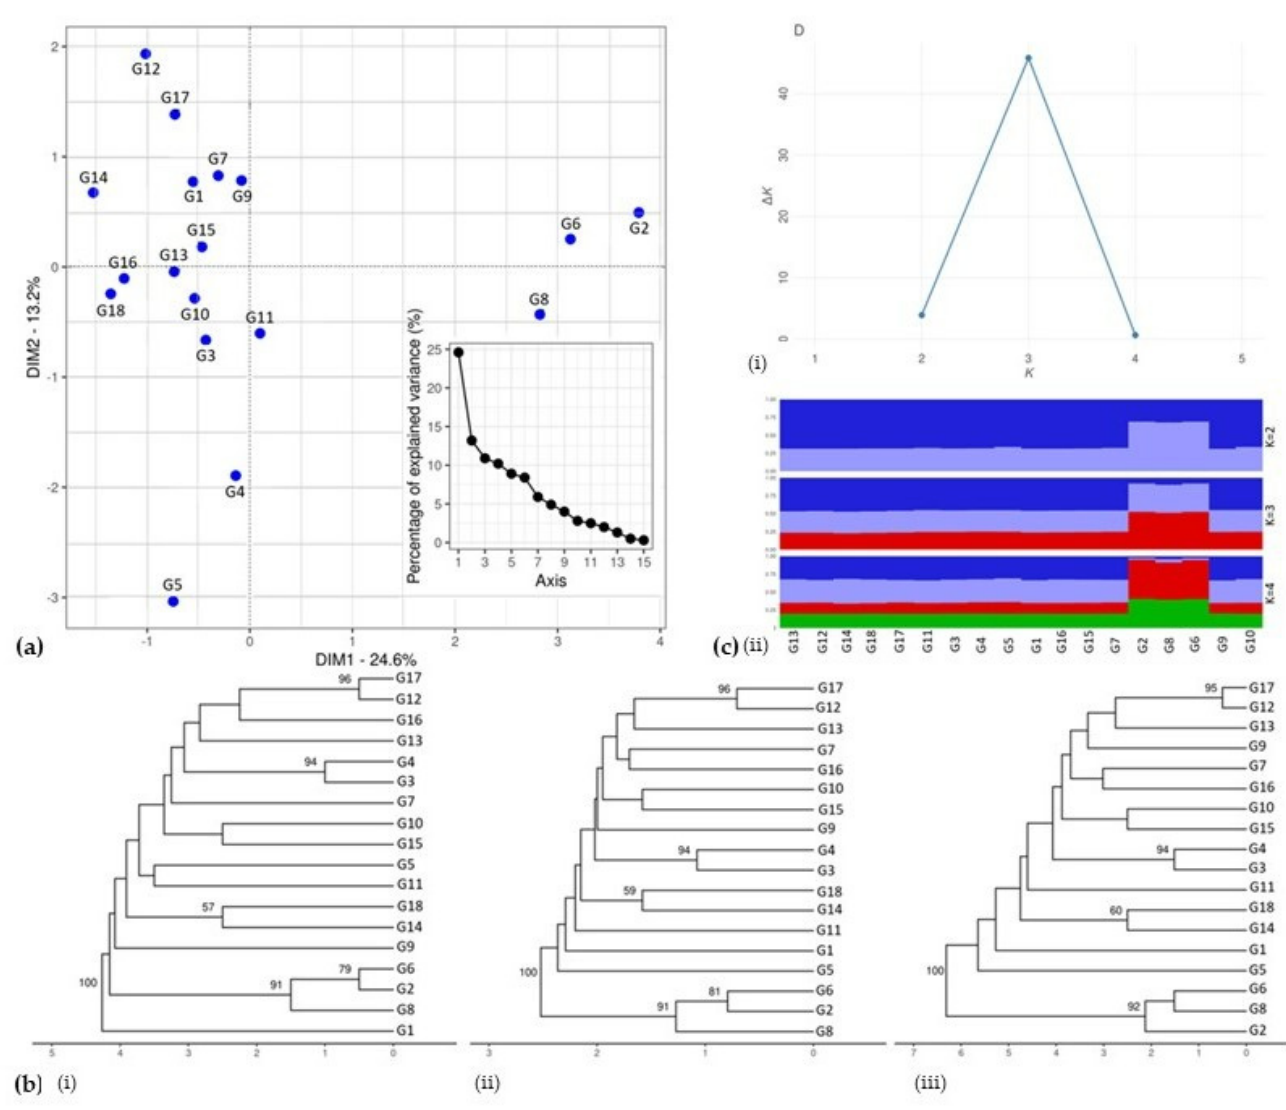
Figure 5. ( a ) Principal Coordinate Analysis (PCoA) plot of 18 native Greek rock samphire genotypes (Table 1) with the percentage of the explained variance (%) demonstrated on the right side of the figure. ( b ) UPGMA dendrogram computed by using three distance measures, i.e., (i) Relative dissimilarity matrix, (ii) Euclidean Distance, and (iii) Smouse and Peakall distance. ( c ) Distribution of 18 rock samphire genotypes according to molecular data of 8 SSR loci in the Structure software with (i) values of Evanno’s Δ K statistic indicating the most probable genetic structure model and (ii) genetic assignment based on STRUCTURE. The individuals are represented by vertical bars; the colors were assigned according to the group formed in the Structure software (three groups, K = 3).